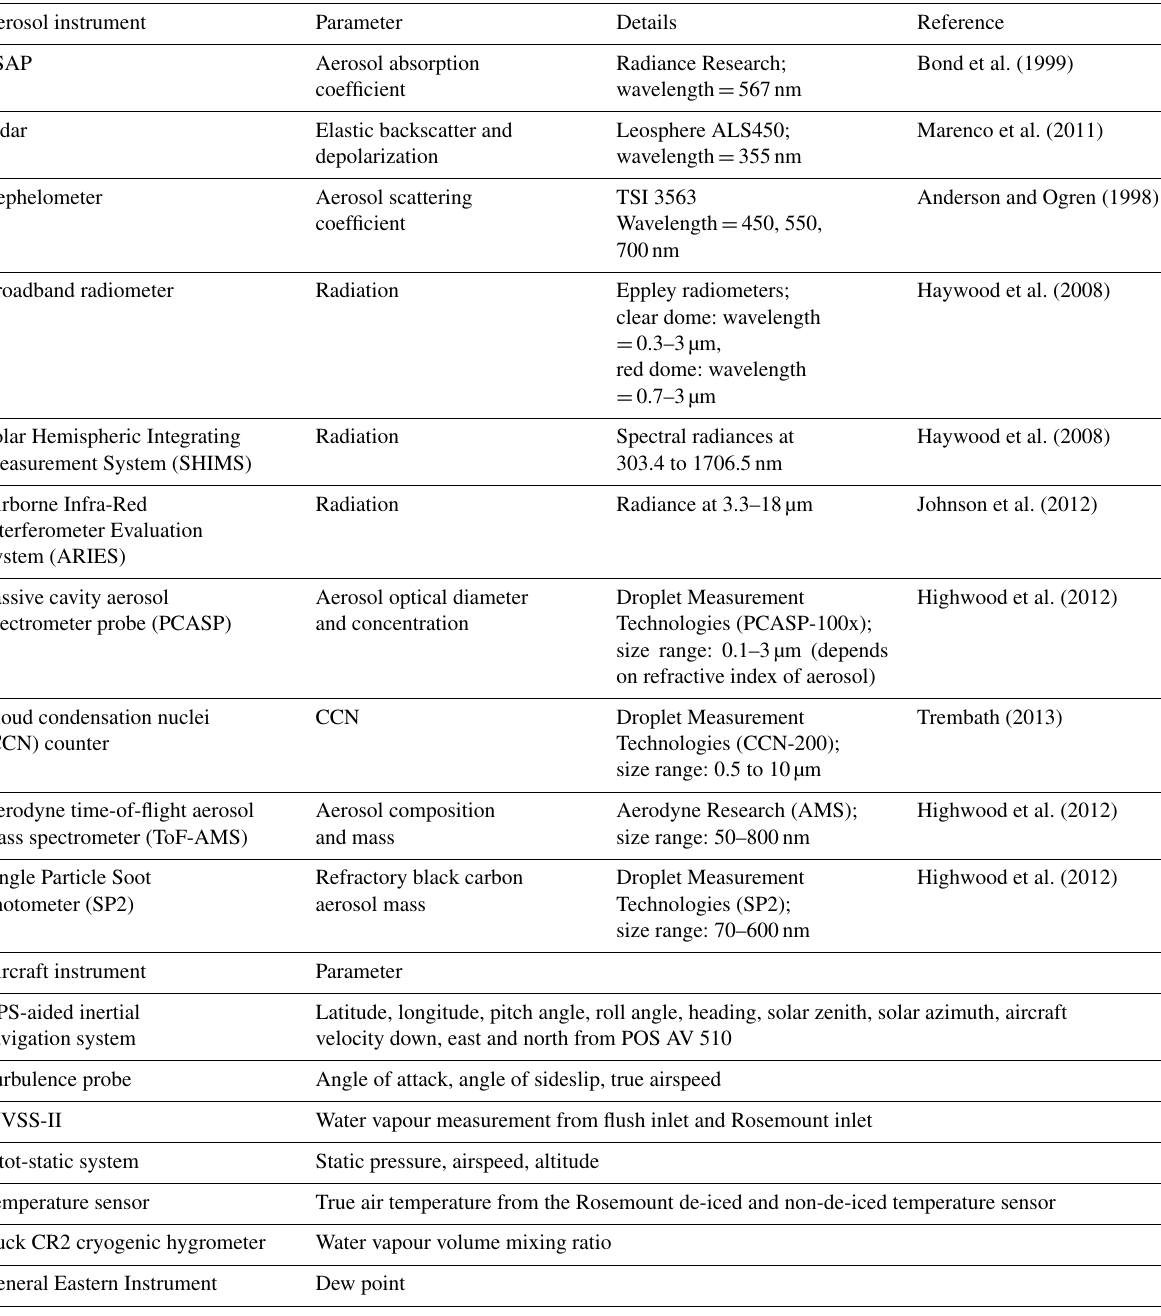
Table 2. Details of aerosol instruments and aircraft instruments measuring various aerosol, meteorological and aircraft parameters. Aerosol instrument Parameter